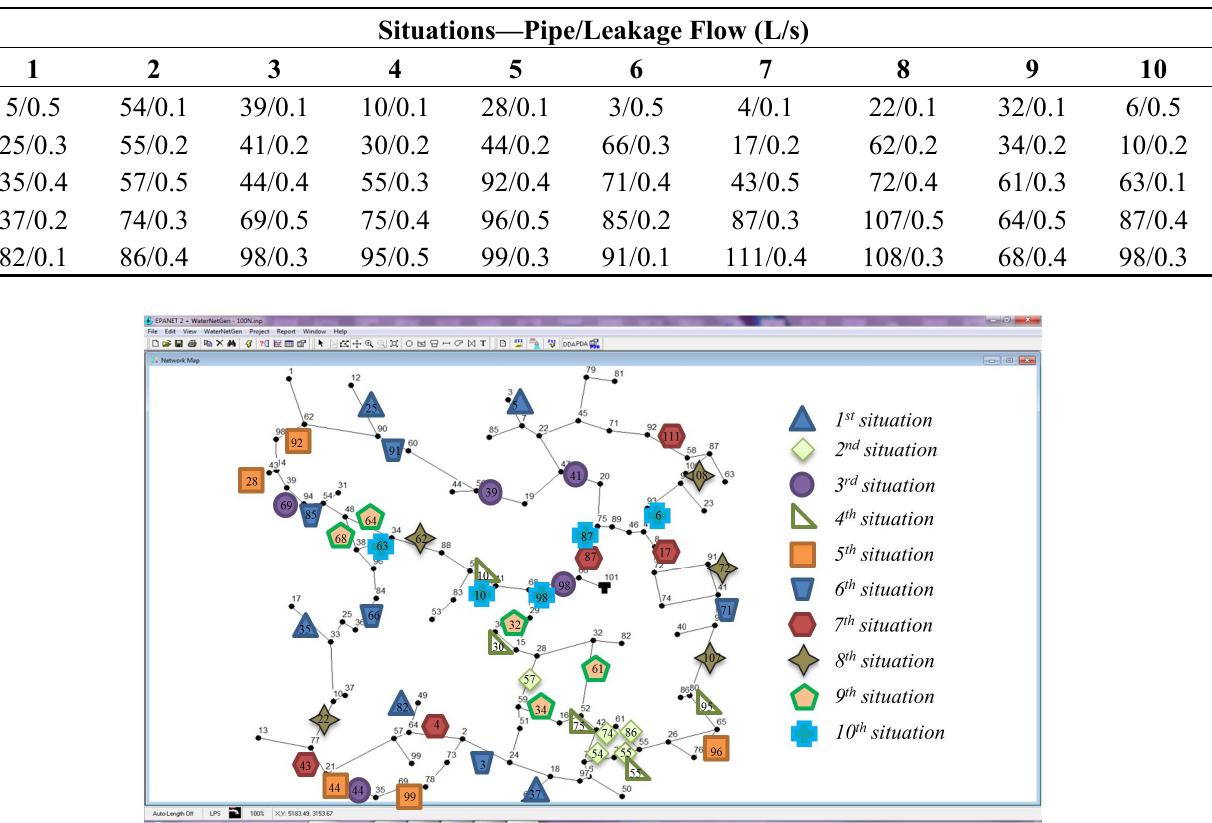
Table 2. Leakage flow spatial distributions (situations) for scenario 1 (1.5 L/s).